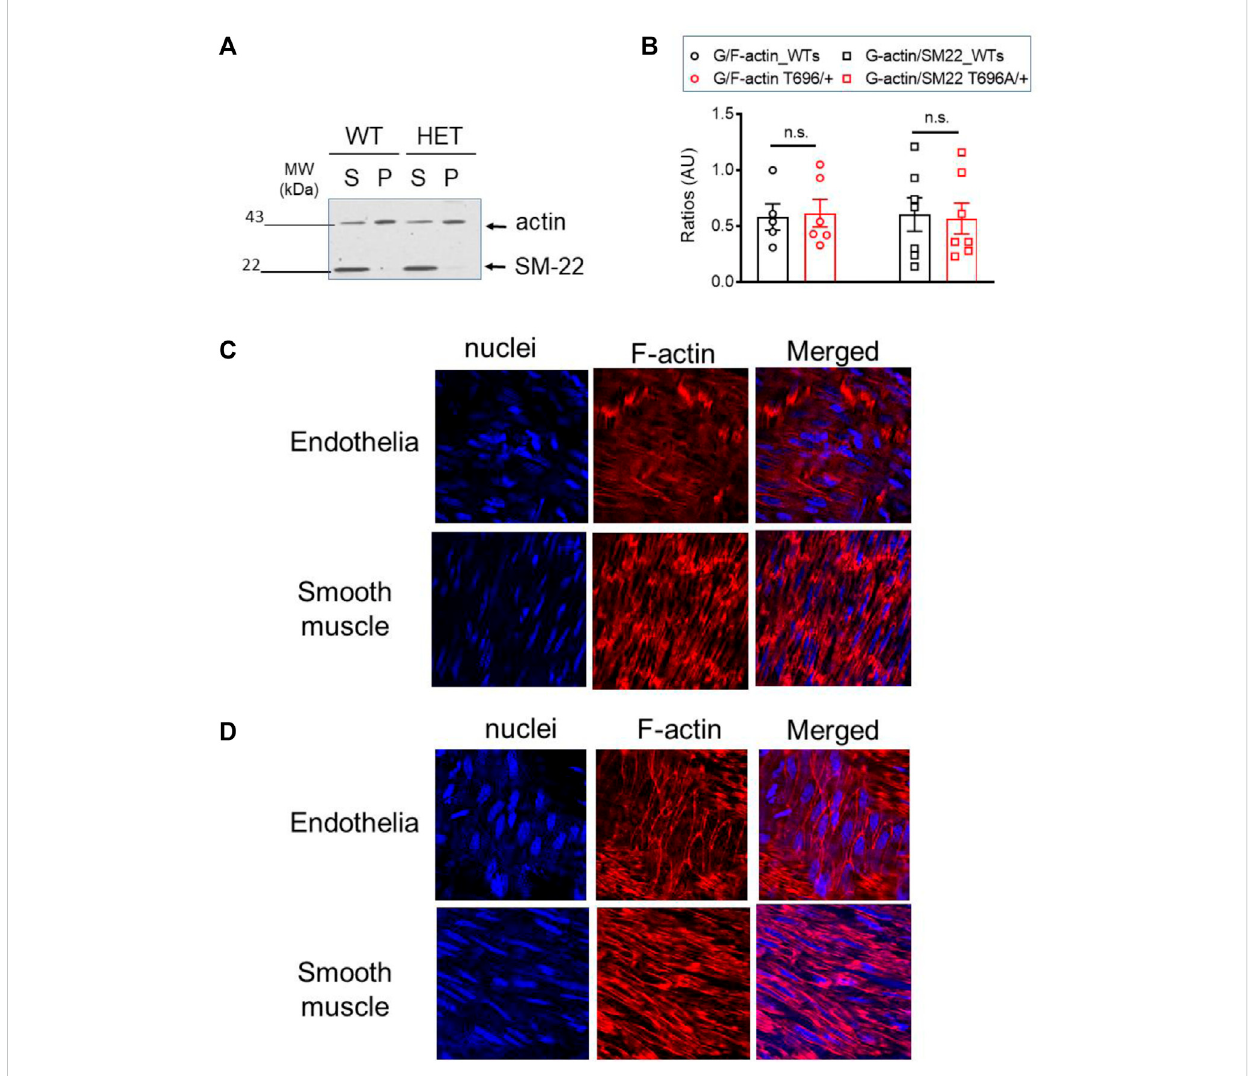
G/F actin ratio in basilar arteries from senescent WT and MYPT1-T696A/+ animals under basal conditions. Localization of F-actin in basilar arteries from senescent WT mice after Calyculin stimulation (A) Original Western blot representing the global actin-immunoreactivity in supernatant (S) used as read out for globular (G) -actin fraction and pellet (P) used as read out for fi brillar (F) -actin in s-BAs from WT and MYPT1-T696A/+ animals. Supernatant and pellet fractions were obtained by ultracentrifugation as described in methods. (B) Statistic evaluation of n = 6 s-BAs, each group. n.s. — not signi fi cant; p > 0.05;two-wayANOVA.Confocalimagesy-BAs (C) ands-BAs (D) arteriesfromWTanimalsstainedwithphalloidinforF-actinandHoechst for Nuclei. Transmission light images are denoted as “ T-light. ” Vessels were isolated, mounted and normalized as described in methods and treated